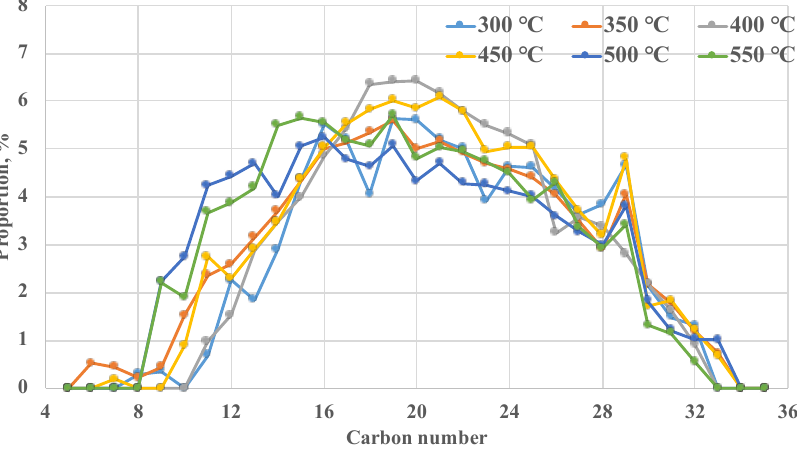
Fig. 4. Proportion of hydrocarbons with different carbon numbers in shale oil at different